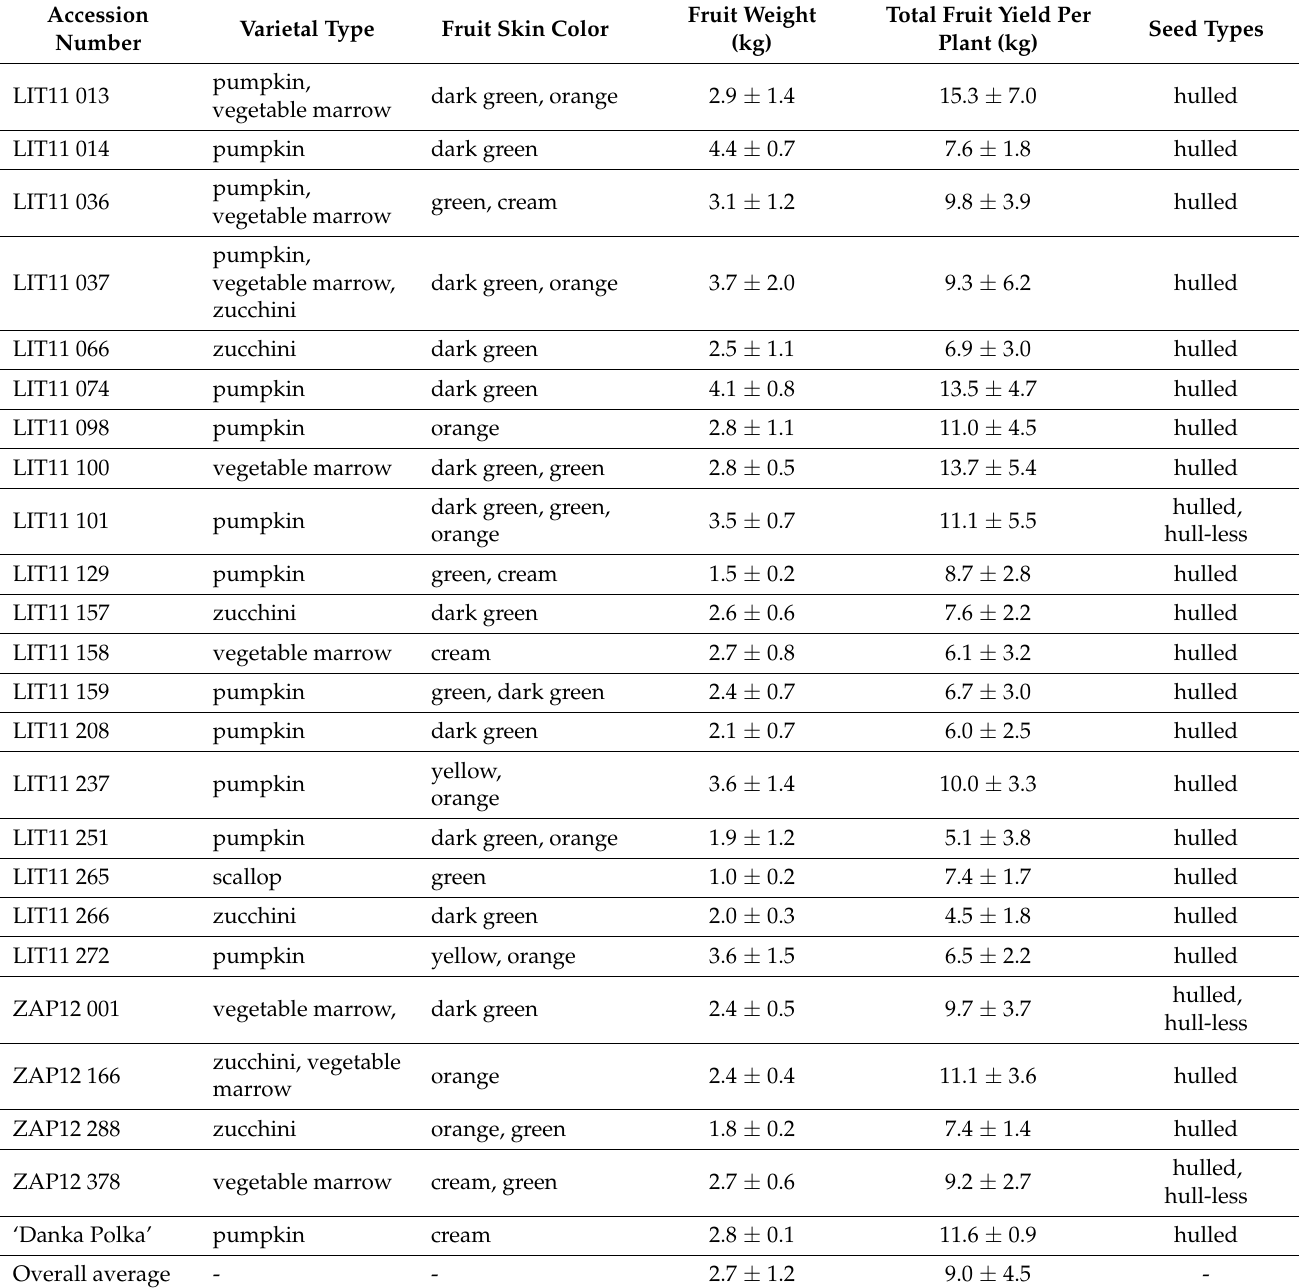
Table 3. Varietal type, fruit, and seed traits of several collected Cucurbita pepo L.